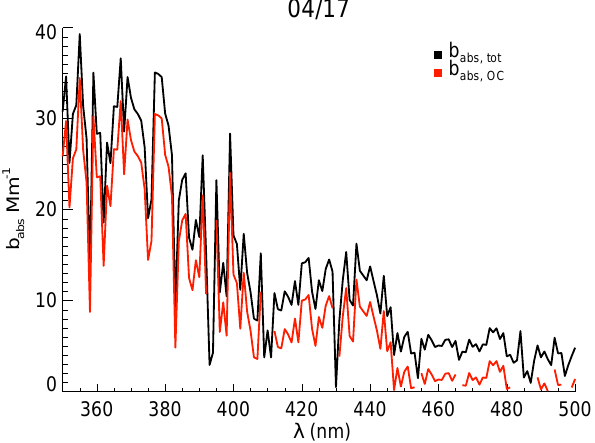
Fig. 7. Spectral b abs,OC ,λ calculated from b abs ,λ using methods out- lined in Arola et al. (2011) for 29 June. Table 3. Contributions of OA to total, UV (350–399nm), and vis- ible (400–500nm) retrieved absorption and for total, 470nm, and 532nm PSAP absorption for 17 April and 29